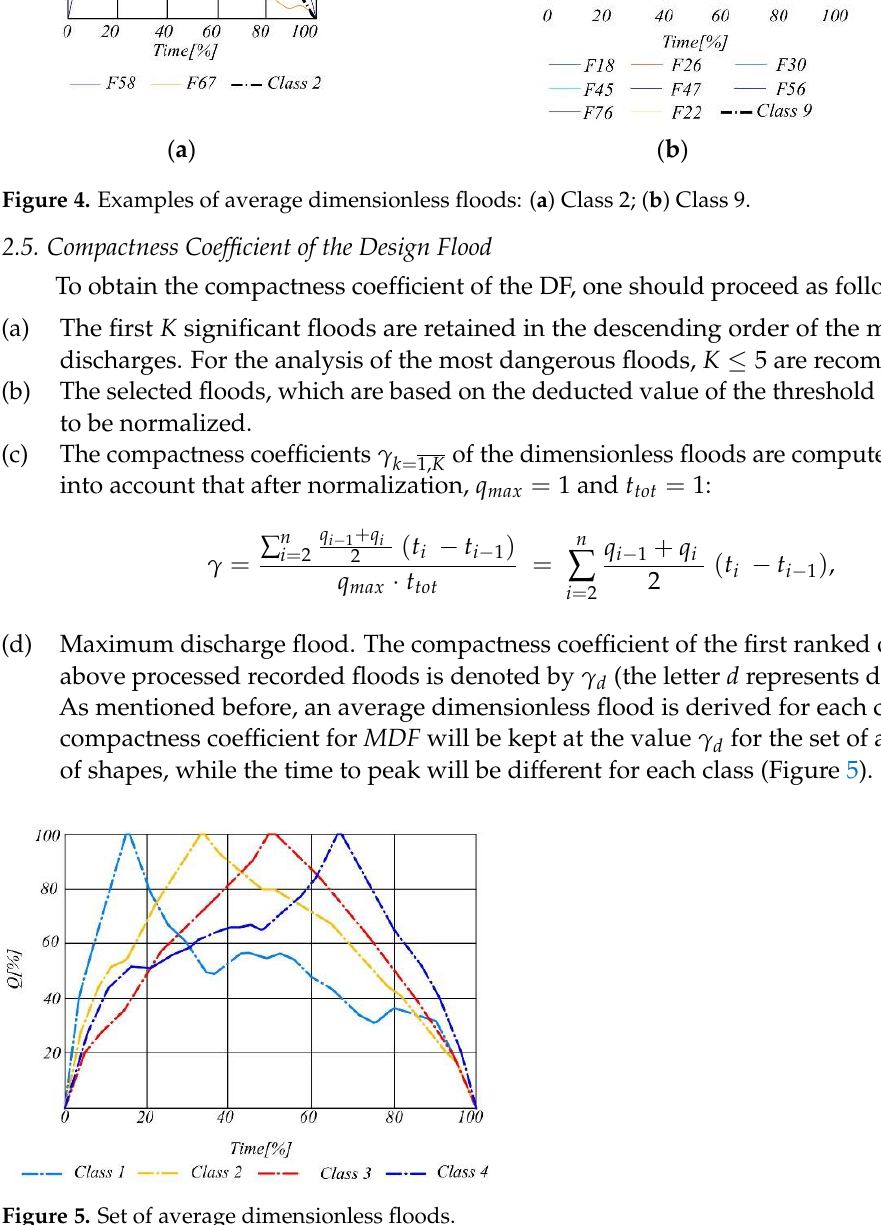
Figure 4. Examples of average dimensionless floods: ( a ) Class 2; ( b ) Class 9.